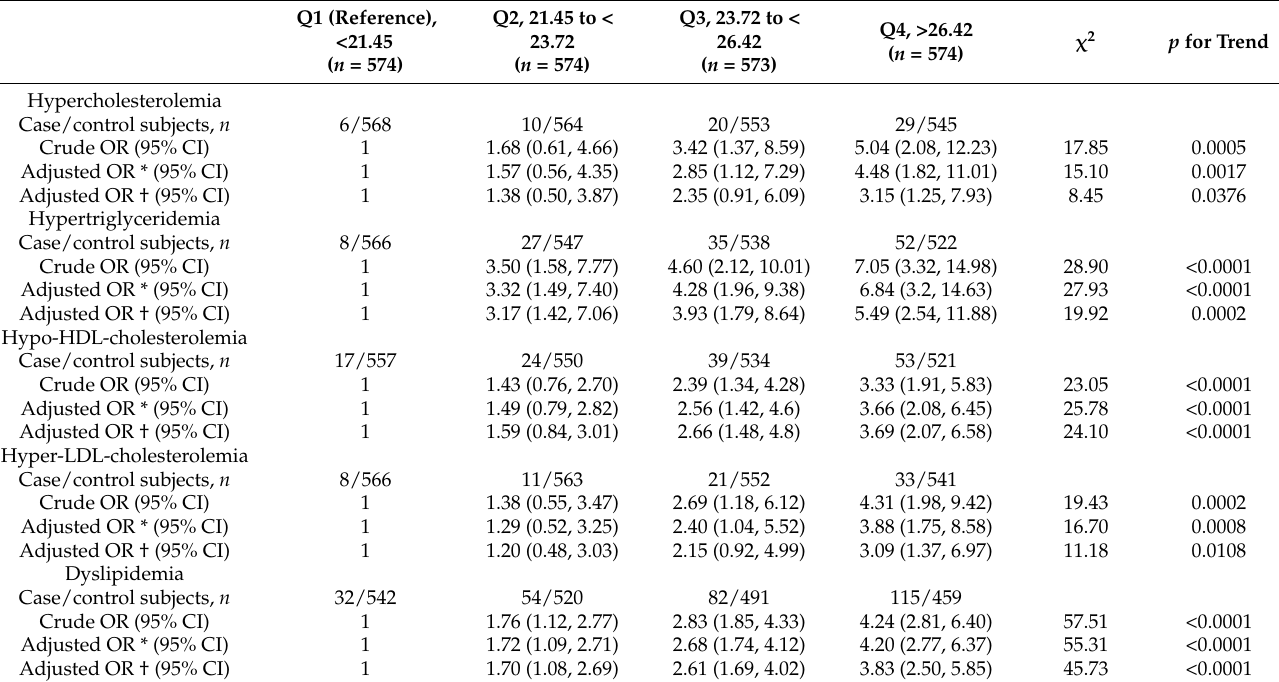
Table 3. ORs (95% CI) of different types of dyslipidemia by quartiles of BMI in lactating women.